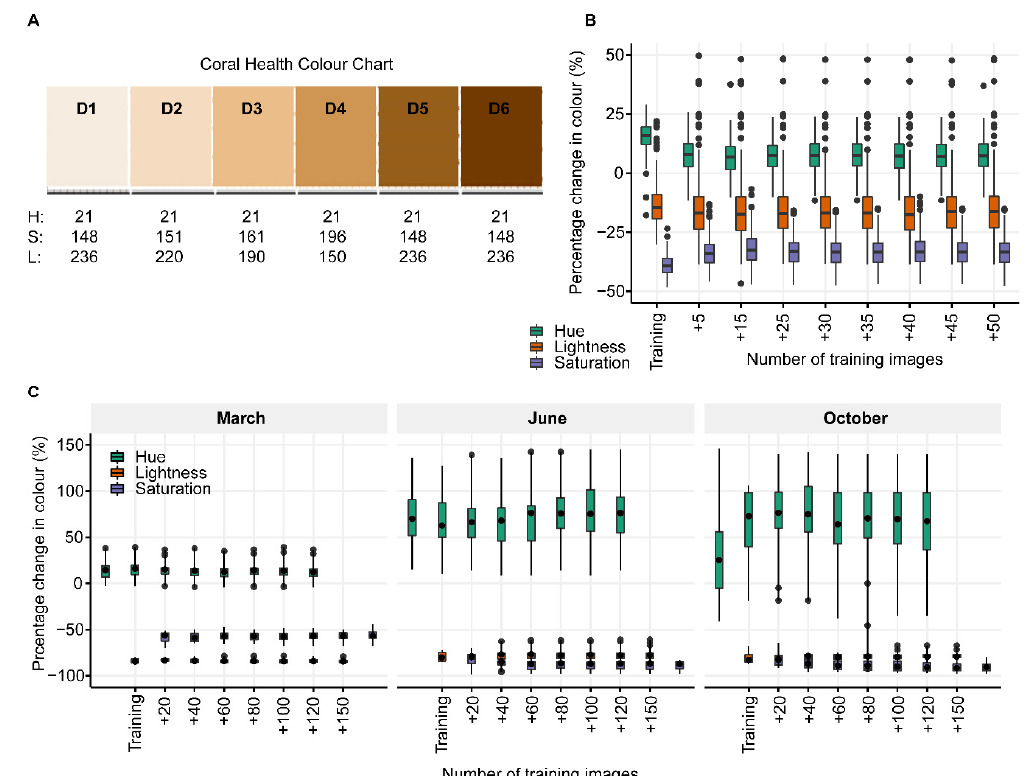
Figure 5. Assessment of machine learning image analysis pipeline for coral juvenile color. Example of the coral color health chart and corresponding values for hue (H), saturation (S), and lightness (L) for the “D” scale [18] ( A ). Boxplots of the percentage change of hue (green), saturation (red), and lightness (blue) between manual and pipeline measurements for the slide ( B ) and tile images ( C ). Facets in ( C ) indicate the time points (month) for which the training images were from. Note that the y-axis for ( B , C ) have different scales. For ( B , C ), if the point is below 0 on the y-axis, the pipeline is under-predicting the HSL. If the point is above 0 then the pipeline is over-predicting the HSL. In the tile images, the hue and lightness measurements did not significantly differ when using more training images for all three time-points (hue: F = 0.989, p = 0.462, lightness: F = 0.675, p = 0.800). However, pairwise comparisons between manual and pipeline measurements showed that saturation, when using the initial training set,